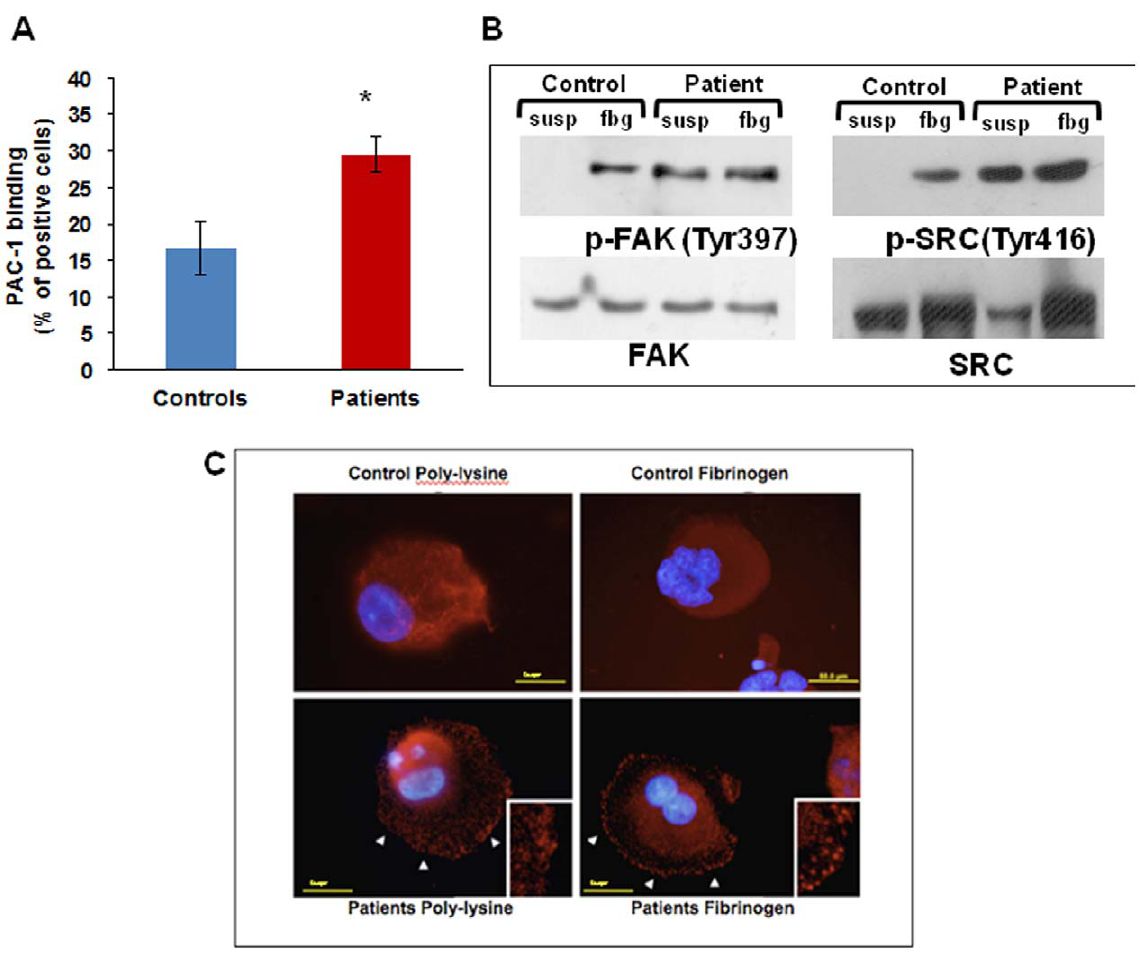
patient megakaryocytes in suspension as well as after adhesion onto fibrinogen. (C) Differently from control cells (upper panels), patient megakaryocytes showed FAK clustering already after 1 hour of adhesion onto fibrinogen, and also in suspension (lower panels).